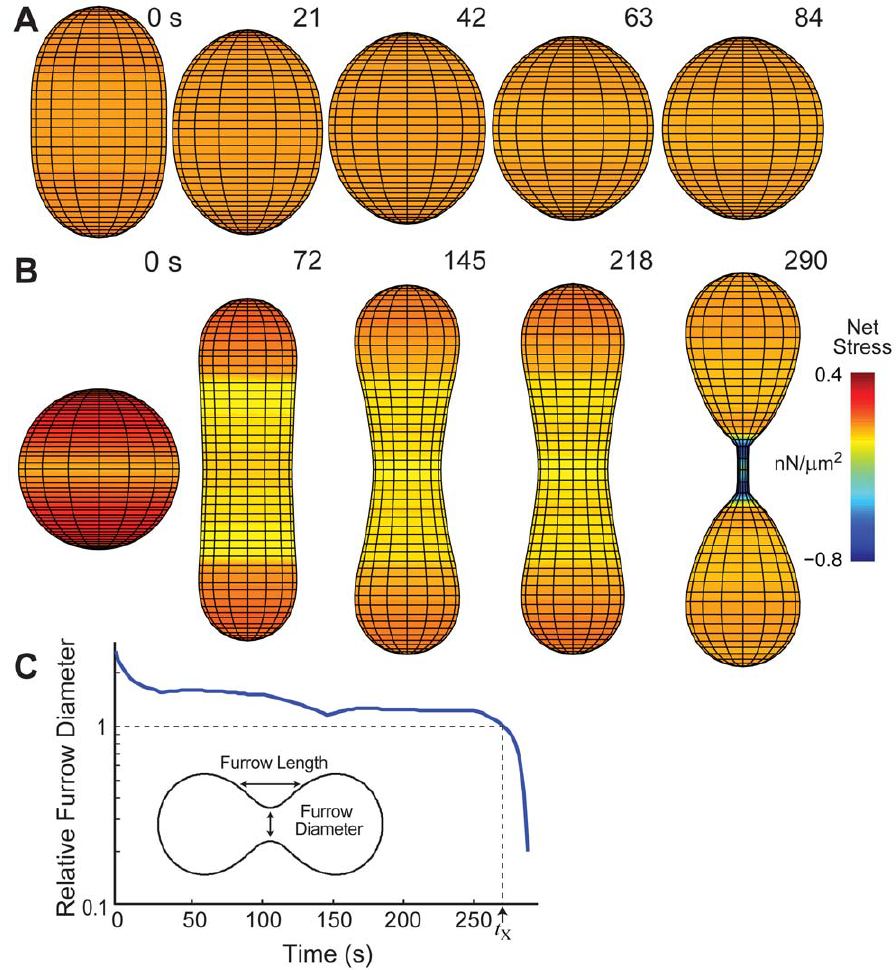
Figure 2. Simulations of interphase cells under various stresses. A. Simulation of a non-adherent cell, initialized as an ellipsoid, experiencing only passive forces. As expected, the cell rounds up relatively quickly. B. Stresses due to adhesion and protrusion were incorporated into the model to simulate traction-mediated cytofission (Video S1). The stress color scale applies for both panels A and B. Negative stress is inward-directed. C. Furrow ingression dynamics of the cell for the simulation in panel B. The point in time when the furrow diameter and length are equal is defined as the cross- over time ( t X ) and this distance is known as the cross-over distance. The relative furrow diameter is the ratio of furrow diameter divided by the cross- over